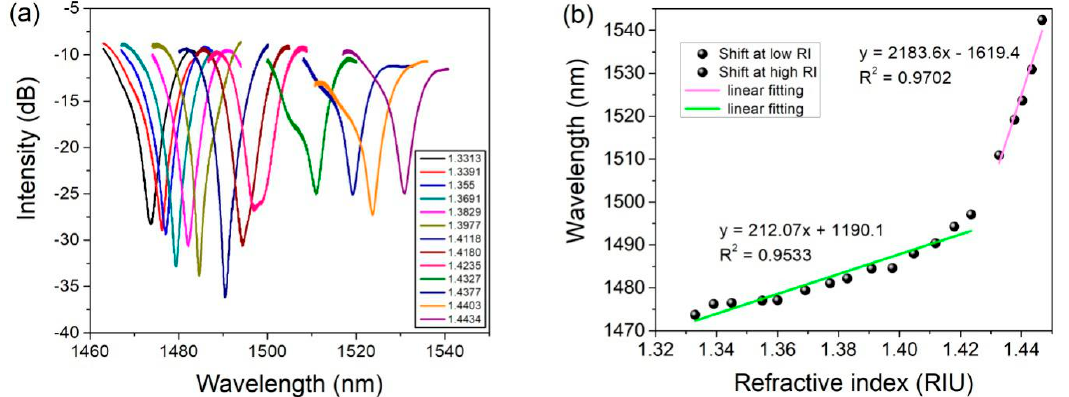
Figure 7. ( a ) The optical spectrum of etched MOF fiber with a diameter of 43 µm; ( b ) The shift of wavelength with the changing of the ambient refractive index (RI).